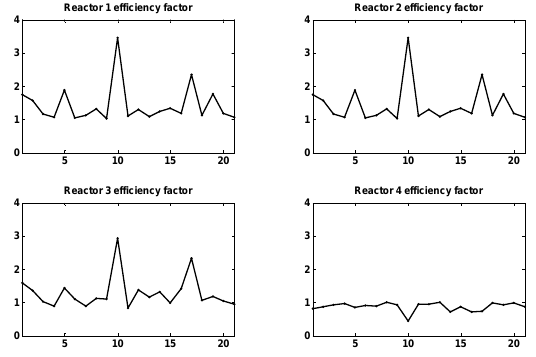
Figure 6: Estimated reactor efficiencies A c for the 21 data sets